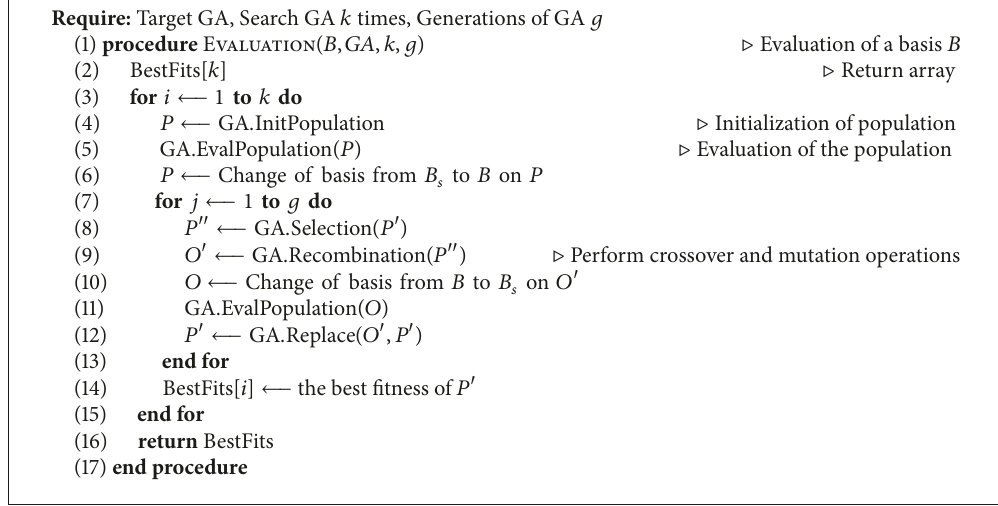
Algorithm 3: Basis evaluation in a